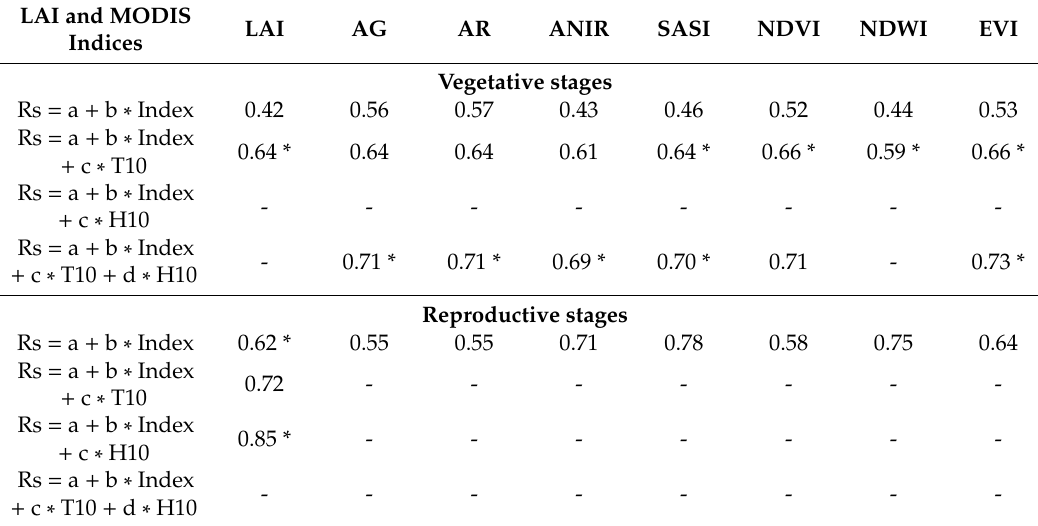
Table 6. Coe ffi cients of determination (R adj2 ) of simple and multiple linear regression models for Rs, as a function of LAI, MODIS spectral indices, soil temperature (T10) and soil moisture (H10) for both years for the vegetative ( n = 22) and reproductive stages ( n = 18) in a rainfed barley crop ( Hordeum vulgare L.) in Madrid, Spain.